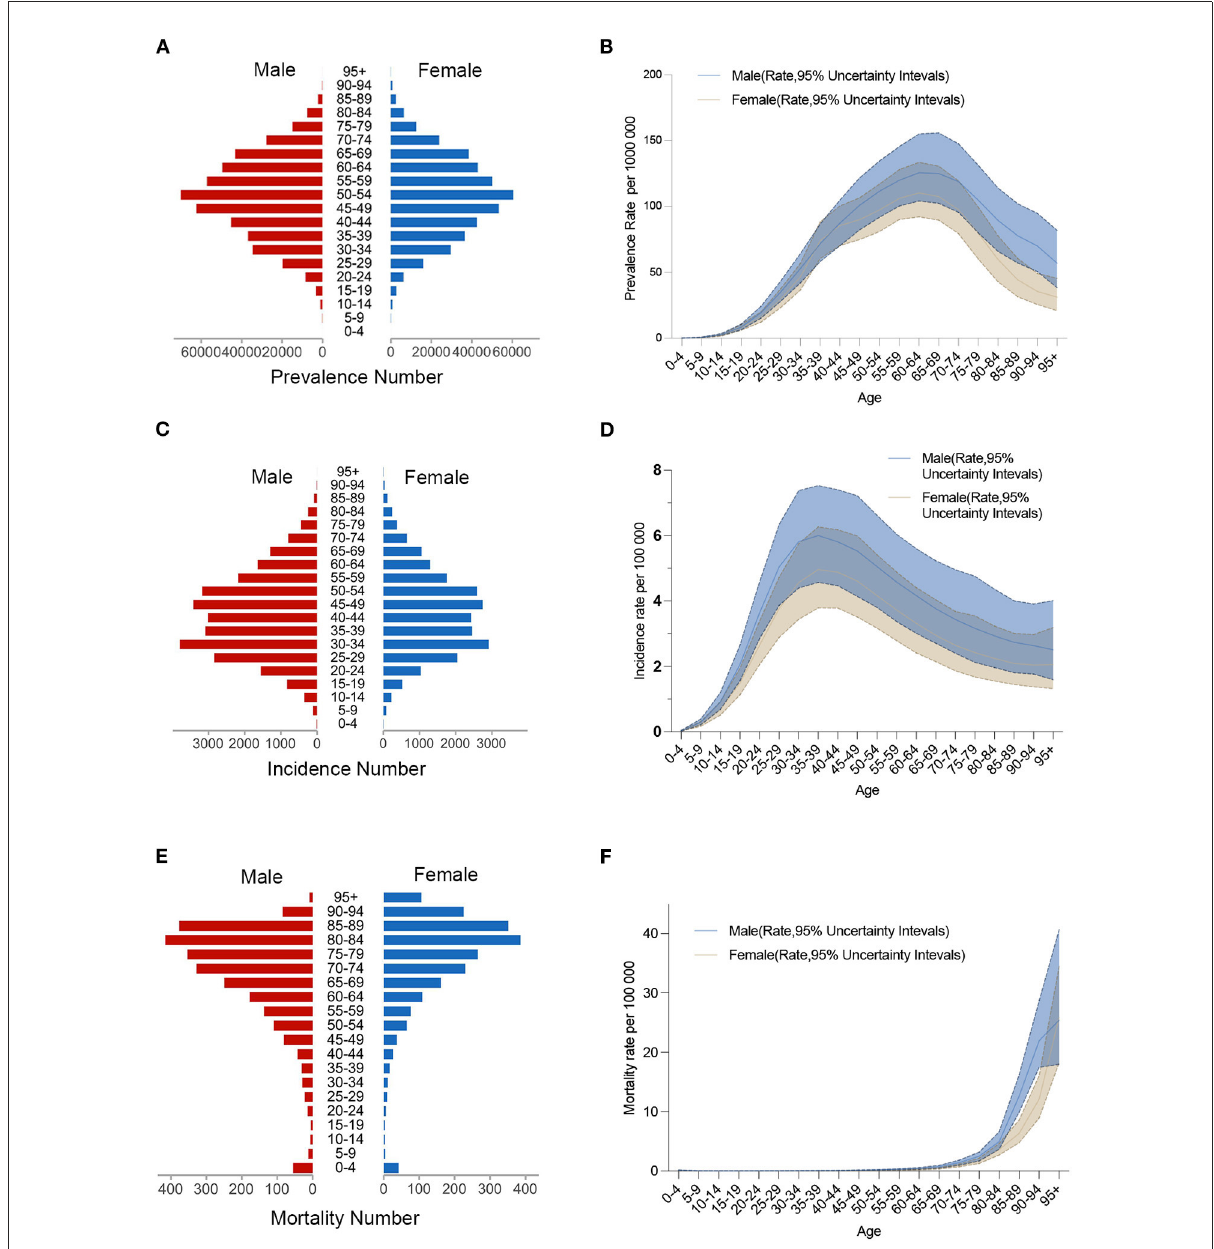
FIGURE1 Age-specific numbers and age-standardized prevalence, incidence, and mortality rates of IBD in China, 2019. (A) Age-specific prevalence number. (B) Age-standardized prevalence rate. (C) Age-specific incidence number. (D) Age-standardized incidence rate. (E) Age-specific mortality number. (F) Age-standardized mortality rate.